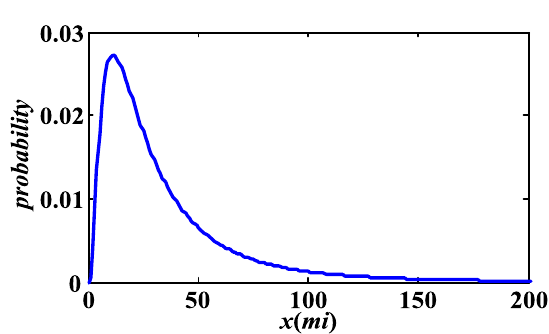
Fig. 2 Probability of driving distance during 1 day